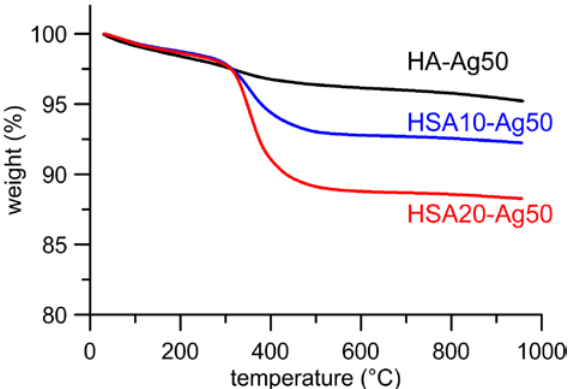
Figure 7. Thermogravimetric plots of HA-Ag50, HSA10-Ag50, and HSA20-Ag50 after 14 days soaking in DMEM .